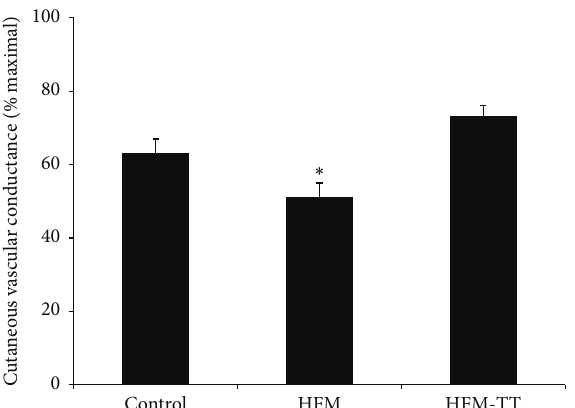
Figure 3: Plateau %CVC max . Plateau %CVC max for the control, high fat meal (HFM), and high fat meal plus TT (HFM-TT) trials. Plateau in the HFM trial was attenuated compared to both the control and HFM-TT trials. There was no difference between the control and HFM-TT trials. ∗ 𝑃 < 0.05 versus control and HFM-TT trials. Data are group mean ± SEM.